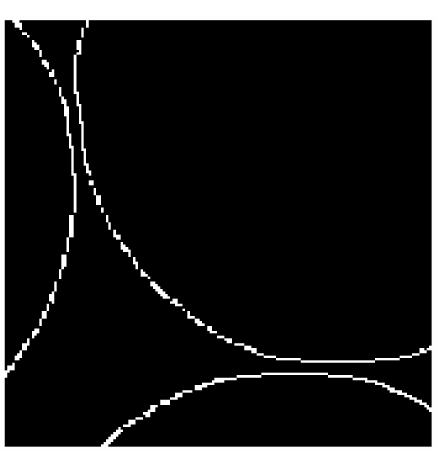
Figure 8. Tangent pearls’